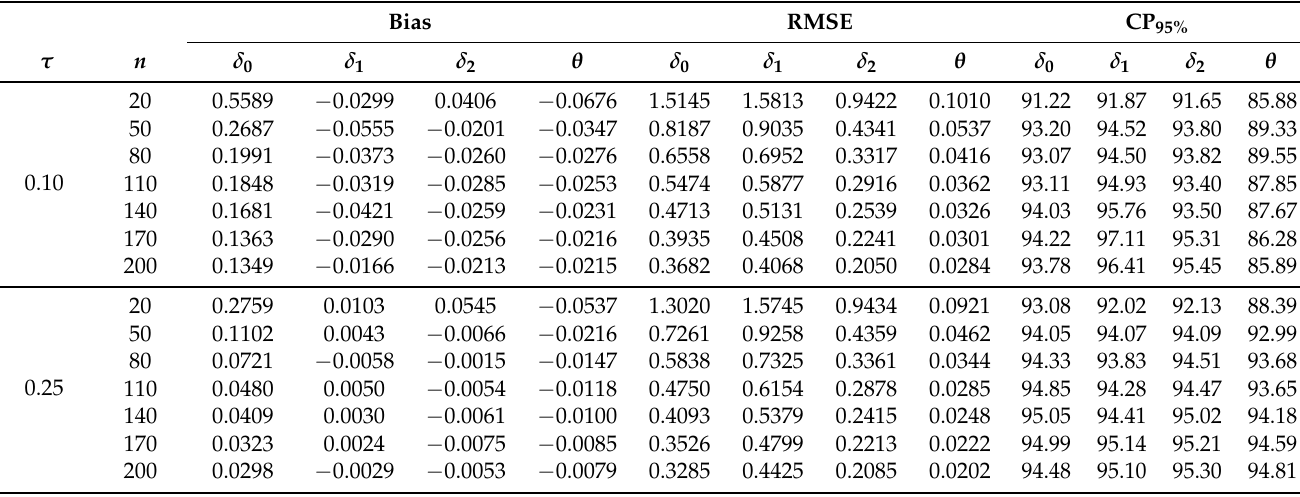
Table 6. Empirical bias, RMSE, and 95% CP (true values: δ 0 = 1.00, δ 1 = 1.00, δ 2 = 0.50, and θ = 0.75) with simulated